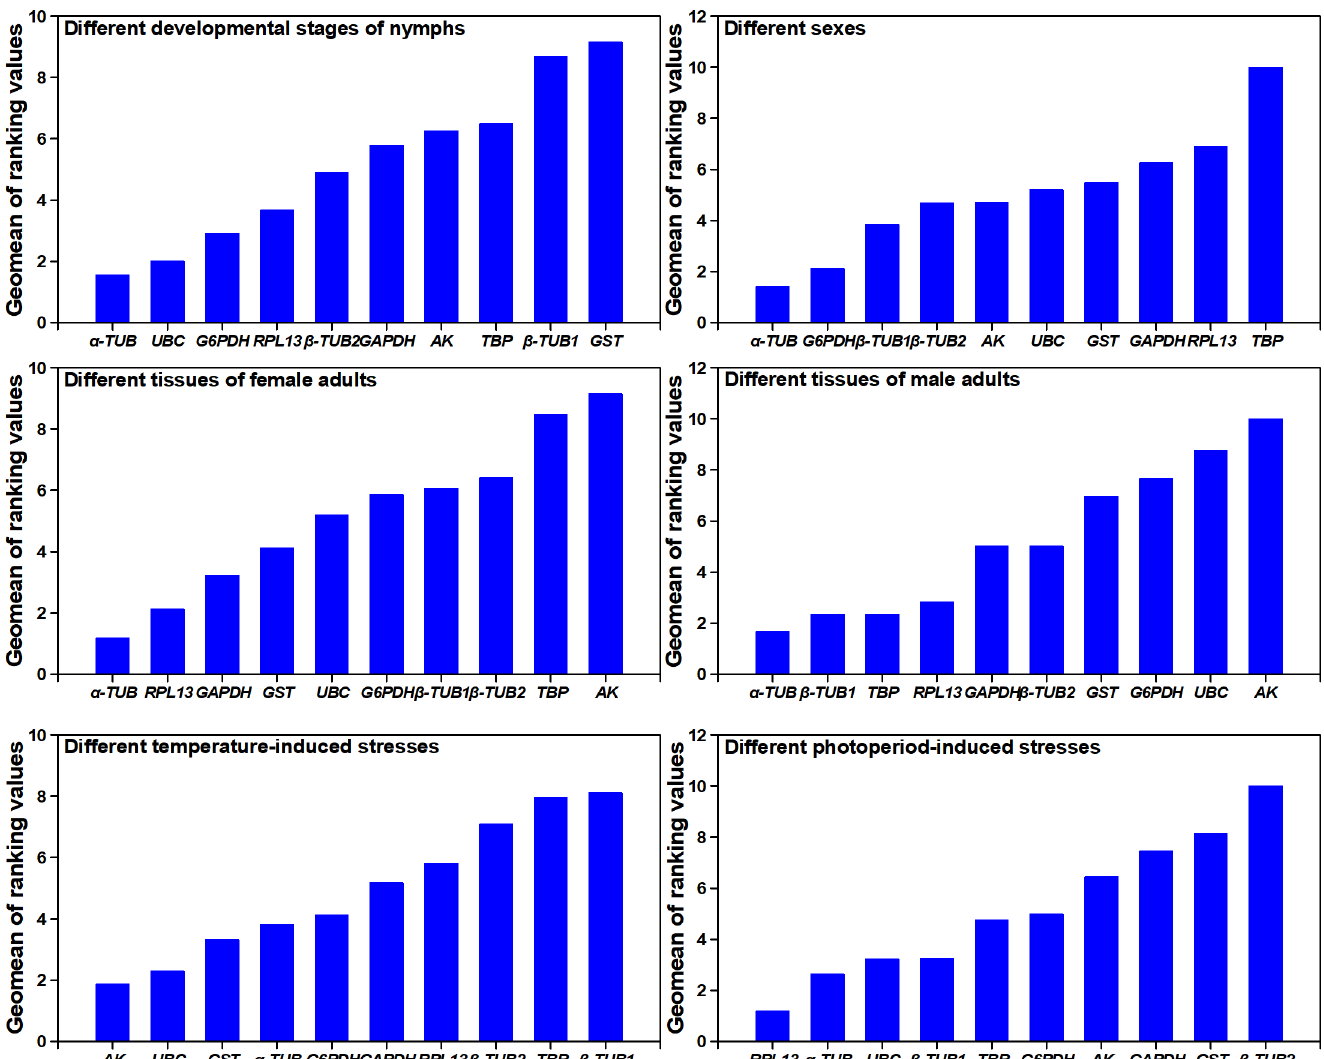
Fig 2. Expression stability of Candidate Reference Genes in E . onukii . The stability of RG expression was measured by RefFinder. A lower geometric mean value represents more stable expression.